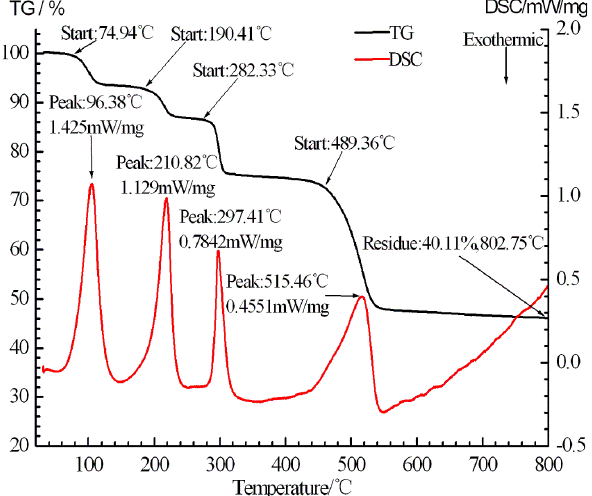
Figure 3: TGA of the crystal MOF-5.